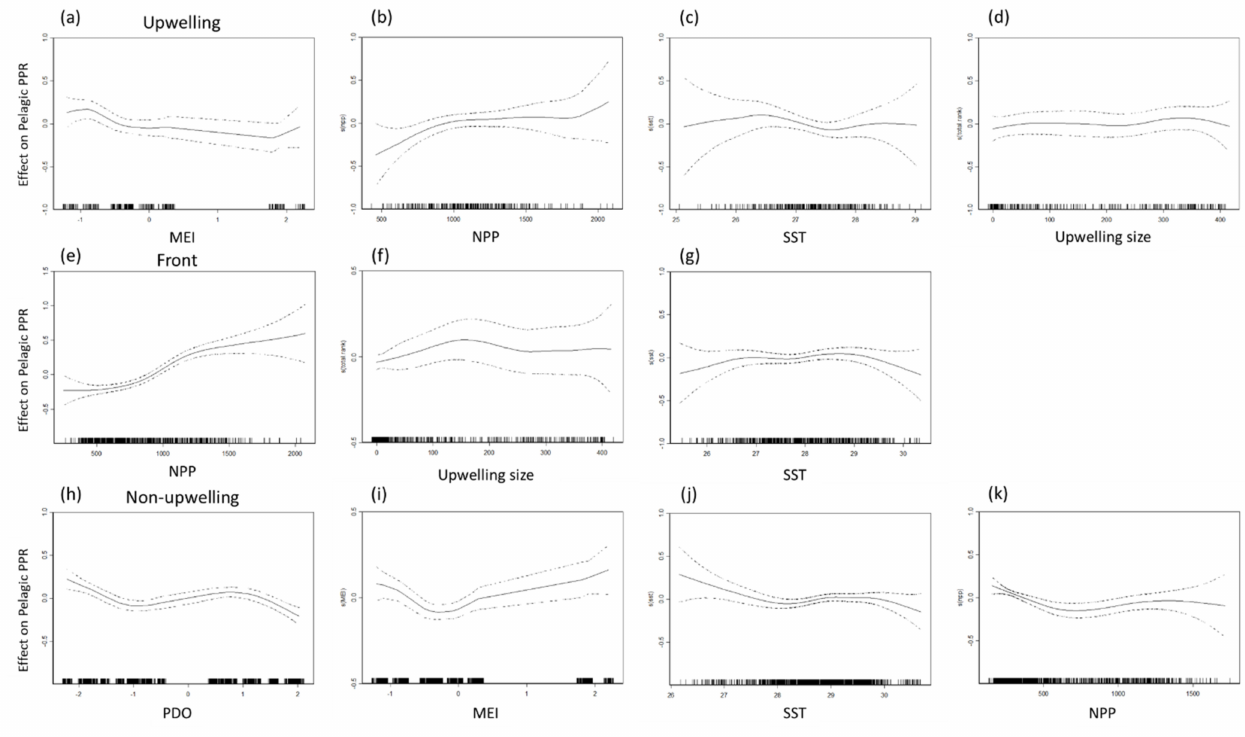
Figure 8. Partial residual plots of the effects of each factor on pelagic primary production required (PPR) in the upwelling habitat ( a – d ), thermal front habitat ( e – g ), and non-upwelling habitat ( h – k